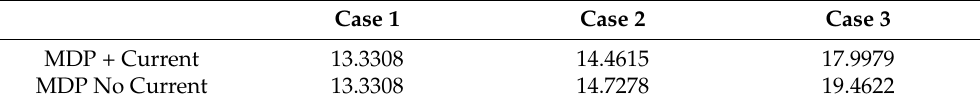
Table 6. Same as Table 5, but the AUV moves along the ocean